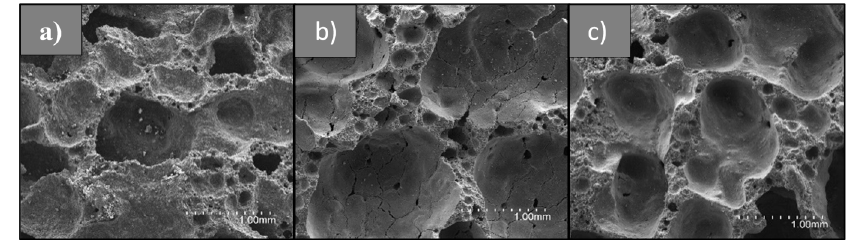
Figure 6. Macrostructure of obtained pAAM, studied by SEM with magnification ×30 : ( a ) FA_0, ( b ) MK_0, ( c ) FA + MK_0.